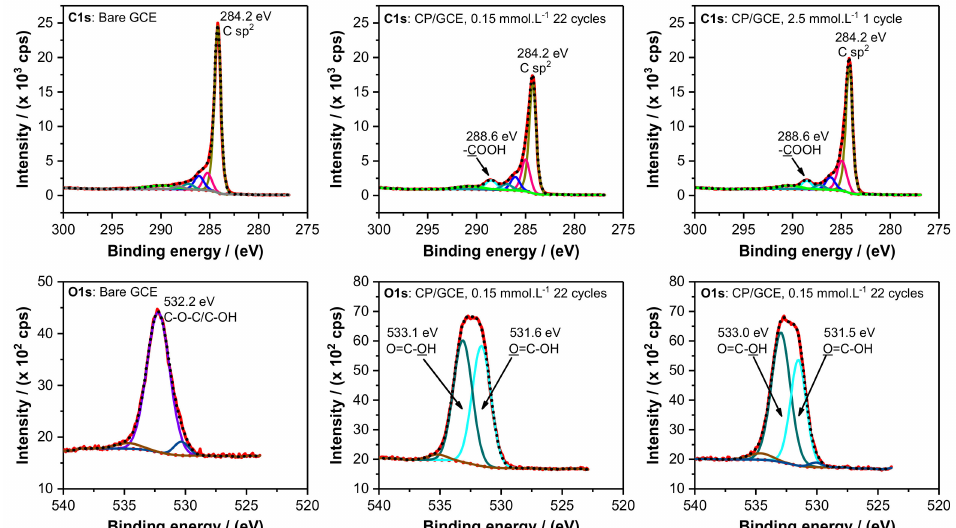
Figure 4. High-resolution spectra of C 1s and O 1s for bare GCE and CP / GCE grafted using 4-CBD: 0.15 mmol / L (22 cycles) and 2.50 mmol / L (1